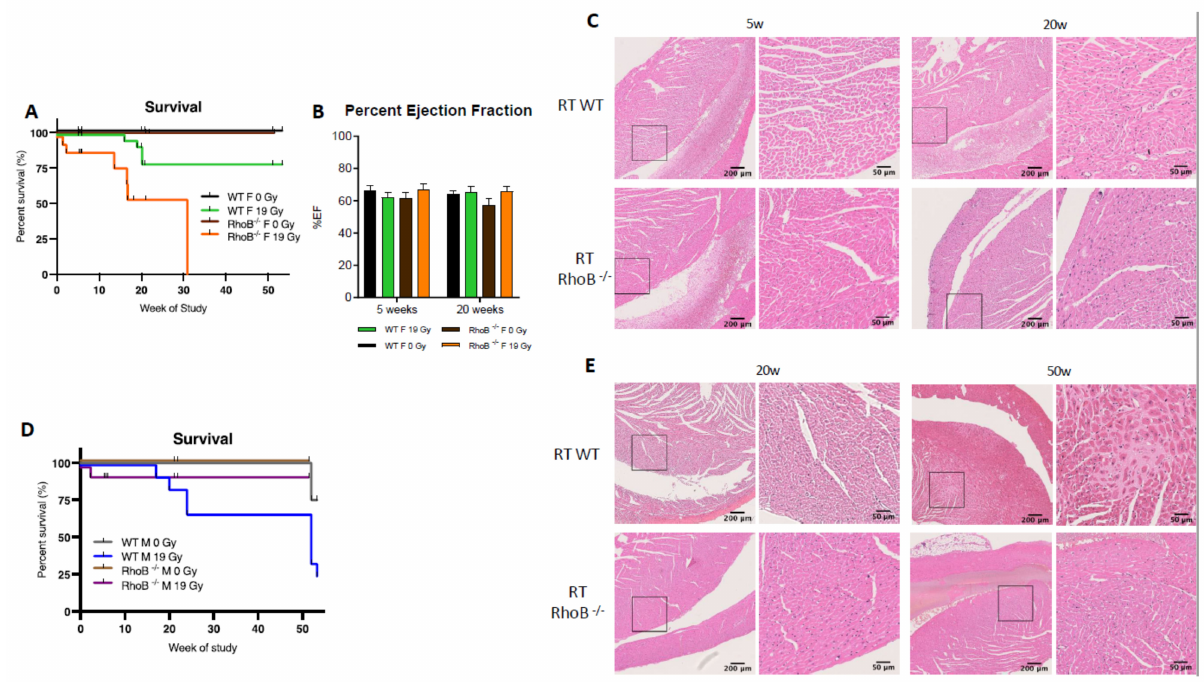
Figure 5. rhoB deficiency reverses cardioprotection in females exposed to RT. ( A ) RhoB- deficient females reached LD100 after 19 Gy thoracic at 30 weeks post-irradiation, whereas WT females exhibit 80% survival. Significant change between rhoB –/– 0 Gy ( n = 14), rhoB –/– 19 Gy ( n = 18), WT 0 Gy ( n = 32), and WT 19 Gy ( n = 32), and female mice exposure survival curves ( p < 0.0001) in log-rank (Mantel–Cox) test. ( B ) No change in %EF was observed in WT and rhoB –/– animals 5 and 20 weeks post-RT. ( C ) H&E staining analysis showed no alteration of the cardiac structure 5 weeks post-RT and enhanced leukocyte infiltration at 20 weeks. ( D ) RhoB- deficient males ( n = 15) were protected from radiation-induced toxicity as compared to WT males ( n = 9). ( E ) H&E staining analysis showed no histologic alteration or fibrosis up to 50 weeks post-RT in rhoB –/– males wheras WT males showed significant